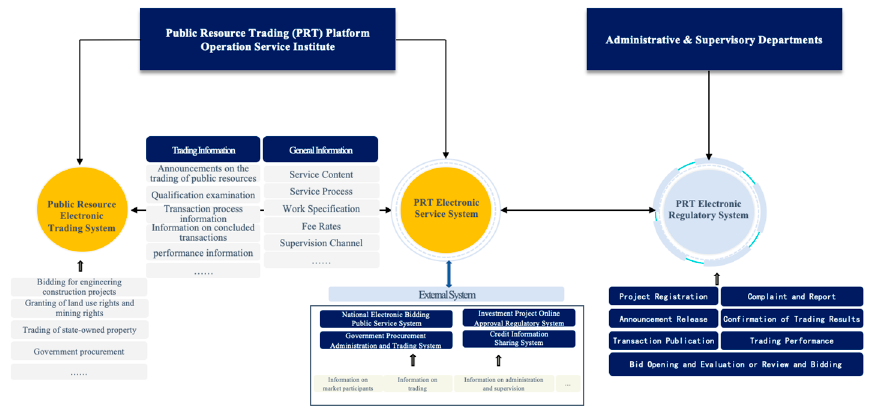
Figure 2. China’s Public Resource Trading Platform System. Source: Interim Measures for the Administration of Public Resources Trading Platforms, http://www.chinatax.gov.cn/chinatax/n810341/n810765/n1990035/201606/c2304070/5118371/files/40d618f83f494486b2586d0405deb7cd.pdf (accessed on 5 February 2023).